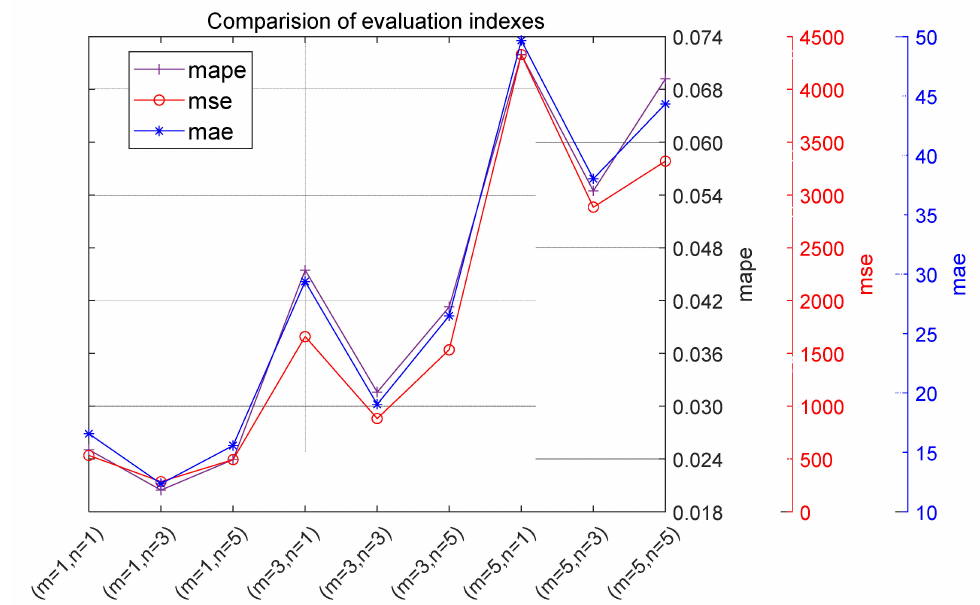
Figure 8. Comparison of evaluation indicators under different values.